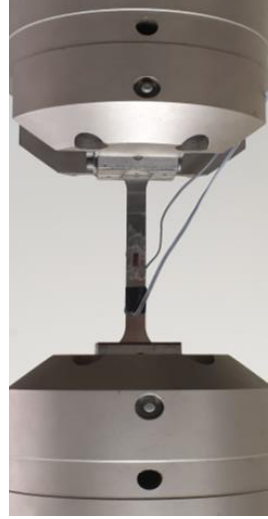
Figure 1. Test setup for direct tensile test.